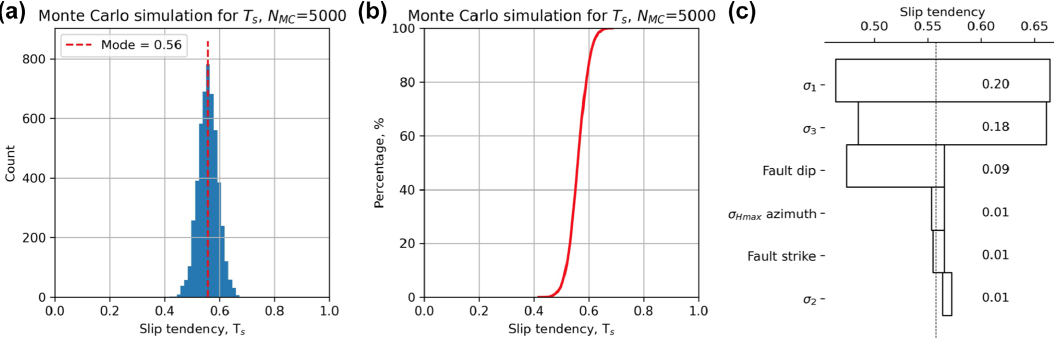
Figure 4. Output from Monte Carlo simulation ( N MC = 5000) of slip tendency ( T s ) calculated using a quadratic response surface from synthetic input data in worked example one. (a) Histogram of calculated T s values, in this case showing a quasi-normal distribution with a mode of ∼ 0.55. (b) Cumulative distribution function (CDF) of calculated T s values, showing the range in values from ∼ 0.4 to ∼ 0.7. (c) Tornado plot showing relative sensitivity to the input variables. The vertical dashed line shows the modal (most-frequent) value of T s from the MC ensemble.